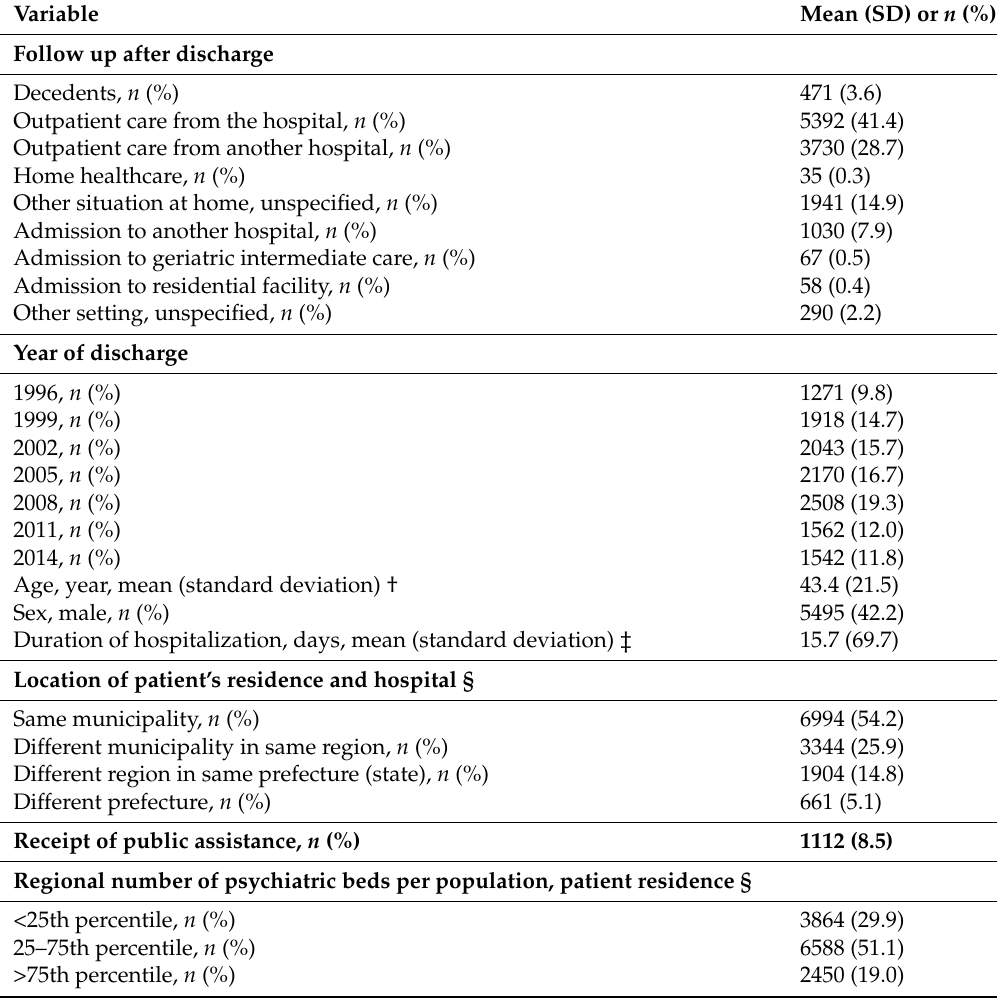
Table 1. Patients admitted to hospital because of deliberate self-harm and subsequently